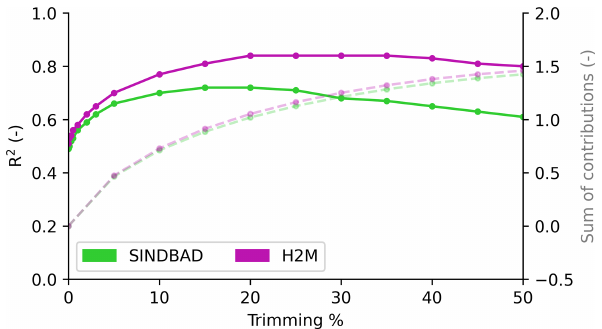
Figure 5. Changes in model performance and errors when pixels with the largest contribution to the variance in global TWS IAV errors are trimmed. Solid lines show changes in R 2 ; dashed lines show the sum of the contributions of the corresponding trimmed- out